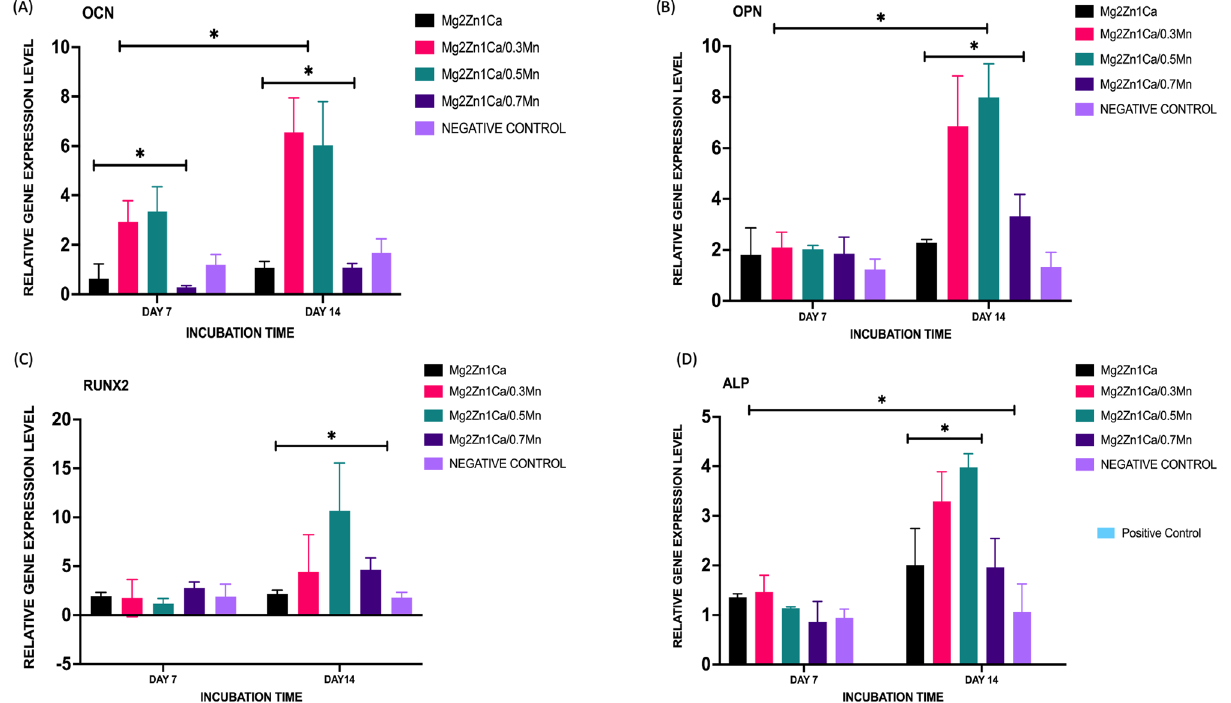
Figure 6. Relative expression level of genes ( A ) Osteocalcin OCN, ( B ) Oteopontin OPN, ( C ) RUNX2, ( D ) ALP in osteoblasts cultured with alloy extracts for 7 and 14 days using SYBR Green RT-PCR. O s teogenic Media with cells were used as negative control and 10% DMSO was used as positive control. Error bars indicate mean ± standard deviation ( n = 3, independent samples). (* P < 0.05)